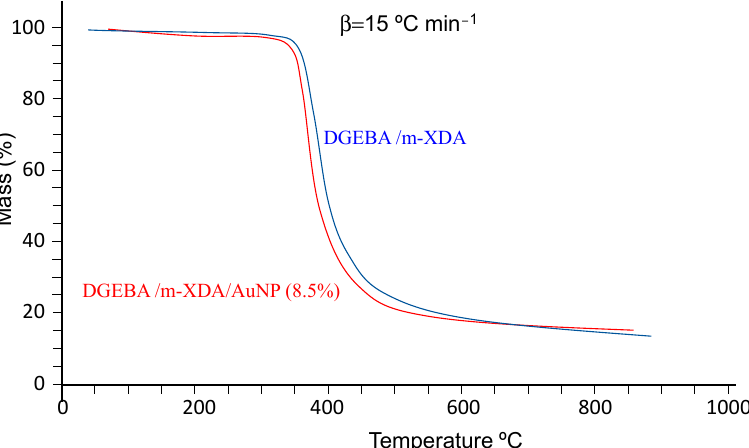
Figure 5. Thermogravimetry experiments for the DGEBA/m-XDA/AuNP (8.5%) at different heating rates ( β ).